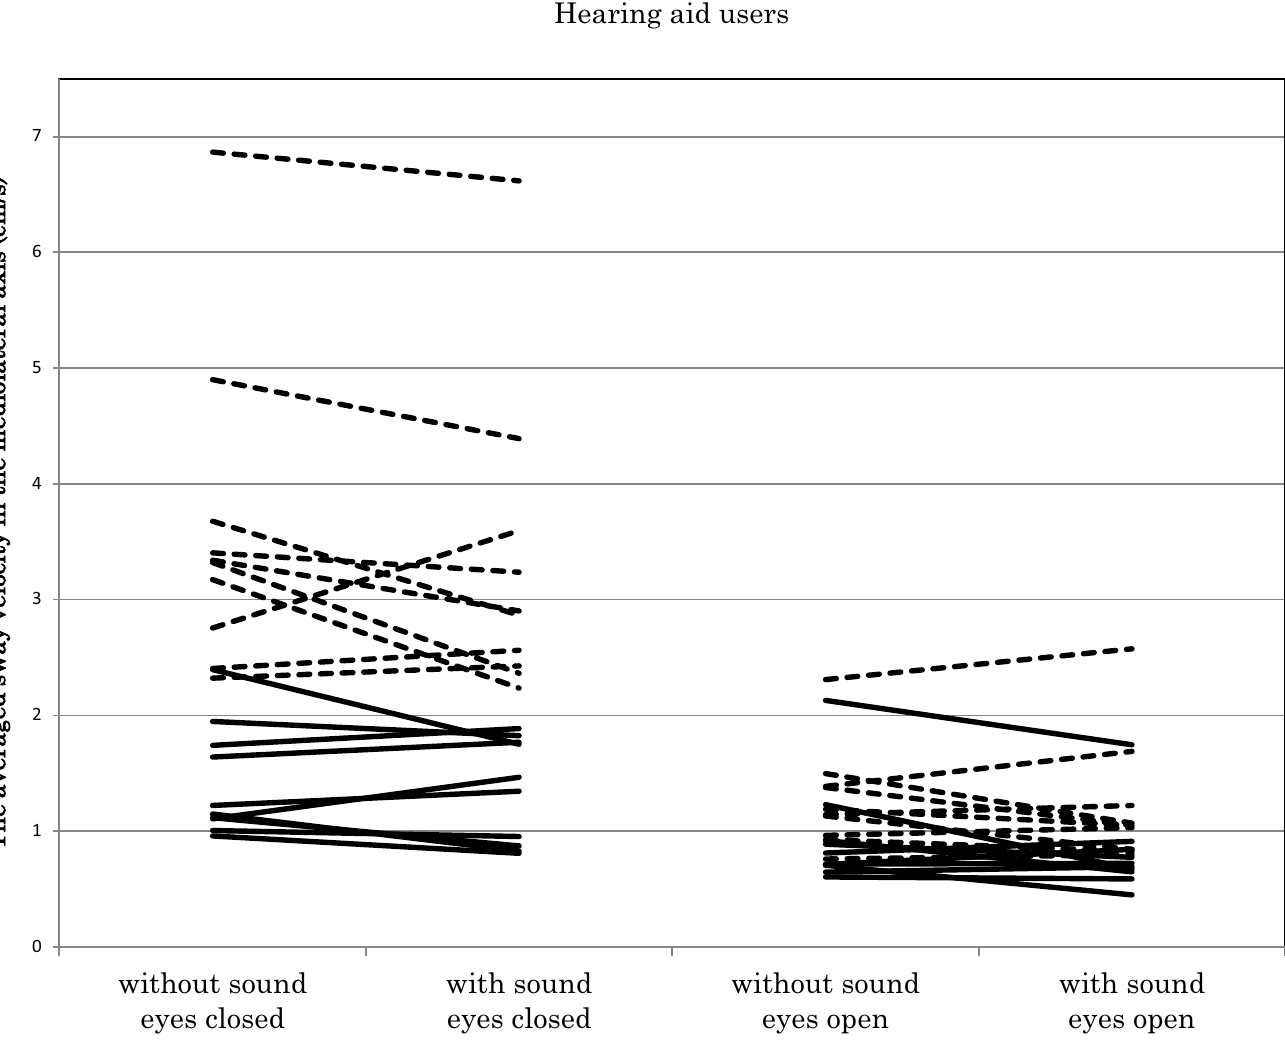
Fig 2. The averaged sway velocity in the mediolateral direction in hearing aid users.